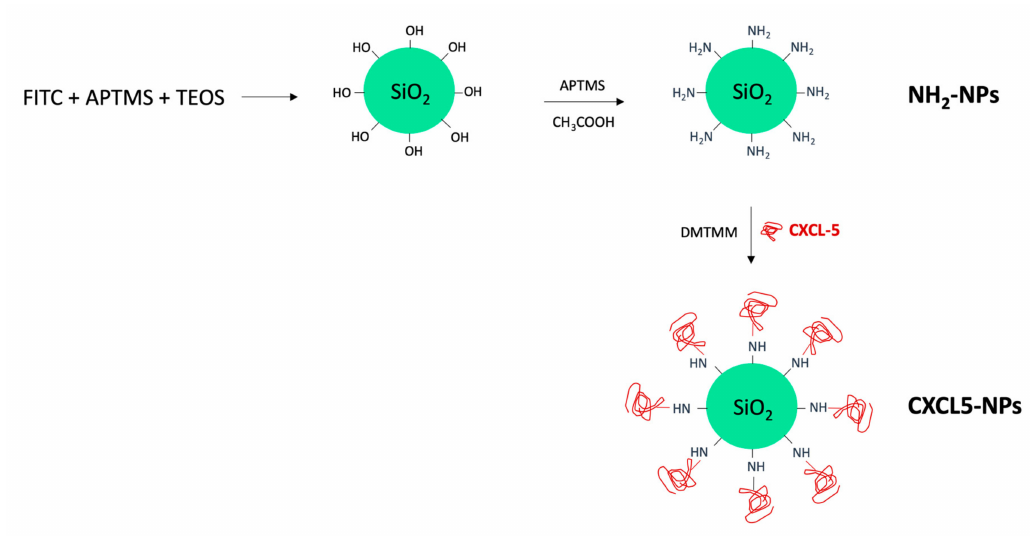
Figure 1. Schematic representation of SiO 2 nanoparticles (NPs) synthesis.